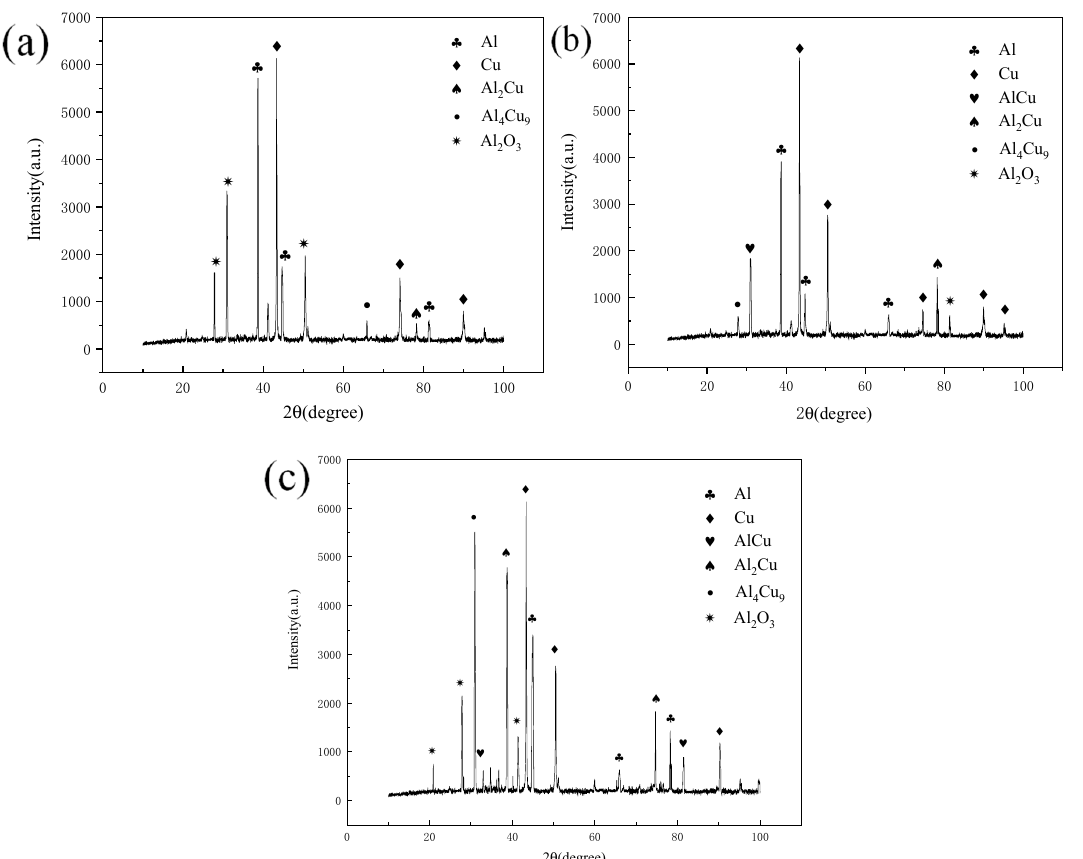
Figure 8. XR diffraction patterns at different annealing temperatures and a holding time of 1.5 h: Figure 8. XR di ff raction patterns at di ff erent annealing temperatures and a holding time of 1.5 h: ( a ) 300 °C; ( b ) 350 °C ; ( c ) 400 °C. ( a ) 300 ◦ C; ( b ) 350 ◦ C; ( c ) 400 ◦